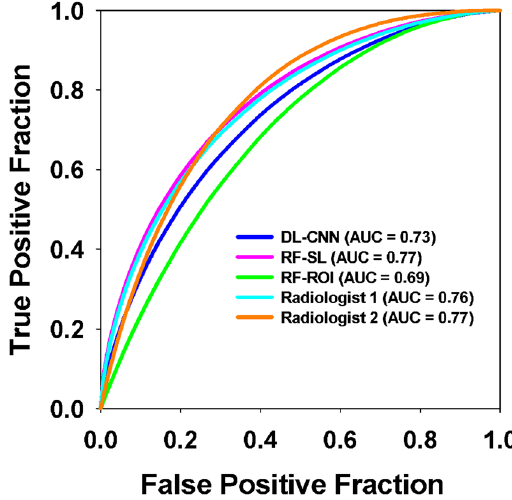
Figure 5. Test set ROC curves for the three models and two expert radiologists. The results from the test set for prediction of T0 stage after neoadjuvant chemotherapy for the three models. The differences between any pairs of AUCs did not reach statistical significance.